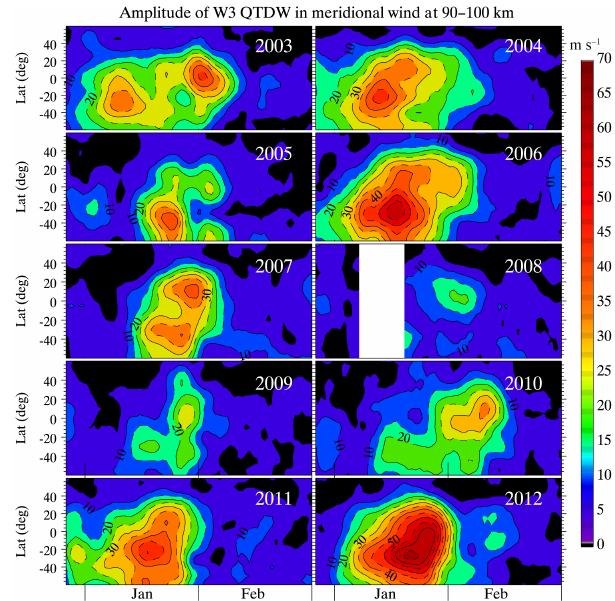
Figure 2. The temporal variations of the wave number 3 QTDW in January and February during 2003–2012. The amplitudes are aver- aged between 90 and 100km.